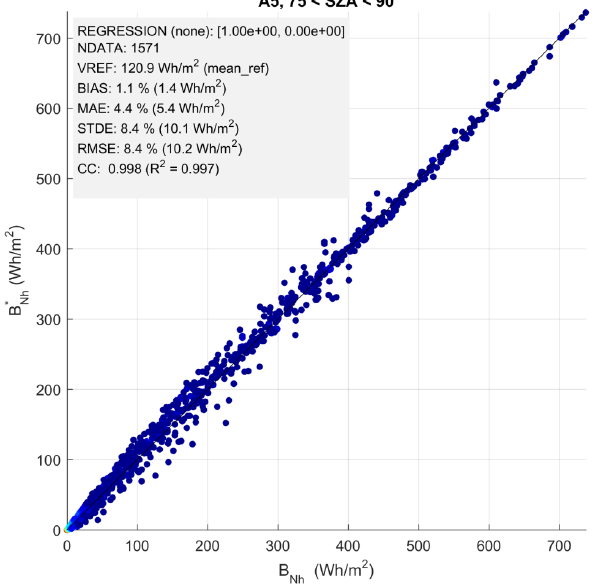
Figure 2. Correlogram between B Nh (horizontal axis) and B ∗ computed with θ eff,A5 (vertical axis) for the subset “low sun” (SZA: S solar zenith angle) for